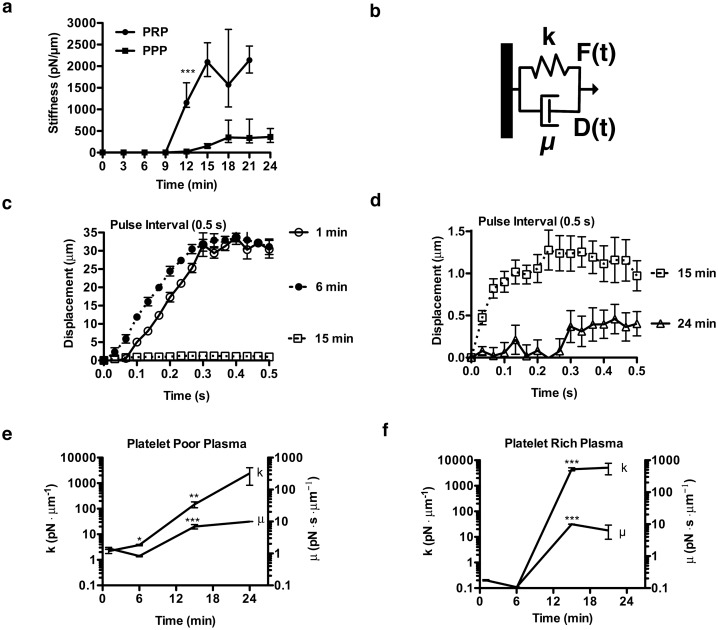
Characteristic mechanical properties of clotting platelet rich (PRP) and platelet poor plasma (PPP) as assessed by application of ARF at 7.5 kHz.(a) Clot stiffness (S), S(t) = Fplasma/Dmavg, of clotting PRP and PPP was determined. Bead displacements (n = 5) were averaged to compute stiffness, which is displayed with 60% quartiles (***, p<0.0005 between PPP and PRP from t > 12 min). (b) In the Kelvin-Voigt model, which predicts the displacement D(t) response of viscoelastic materials to applied force F(t), a viscous element (dashpot) is in parallel with an elastic element (spring). The parameters k and μ describe the elastic and viscous properties respectively. (c-e) The Kelvin-Voigt model was fit to bead displacement data in clotting PPP (c) where displacement decreased abruptly between 6–15 min. (d) From 15–24 min the model was fit to bead displacement data and displacement continued to decrease. At all time points, in contrast to measurements in the viscous fluids, the displacement approached a maximum. Standard error is shown with n = 5 beads per time point. (e-f) Kelvin-Voigt viscous (μ) and elastic (k) parameters of PPP and PRP were determined. Standard error is shown with n = 5 beads per time point (*, p<0.05)(**, p<0.006)(***,p<0.0005). (e) During clotting in the PPP sample the Kelvin-Voigt viscous (μ) and elastic (k) parameters increased 1107 fold and 6.9 fold respectively. (f) During clotting in the PRP sample the average fold difference of viscous (μ) and elastic (k) parameters of the clot as compared to PPP between 15 and 21 min were 1.3 fold and 11 fold larger, respectively.